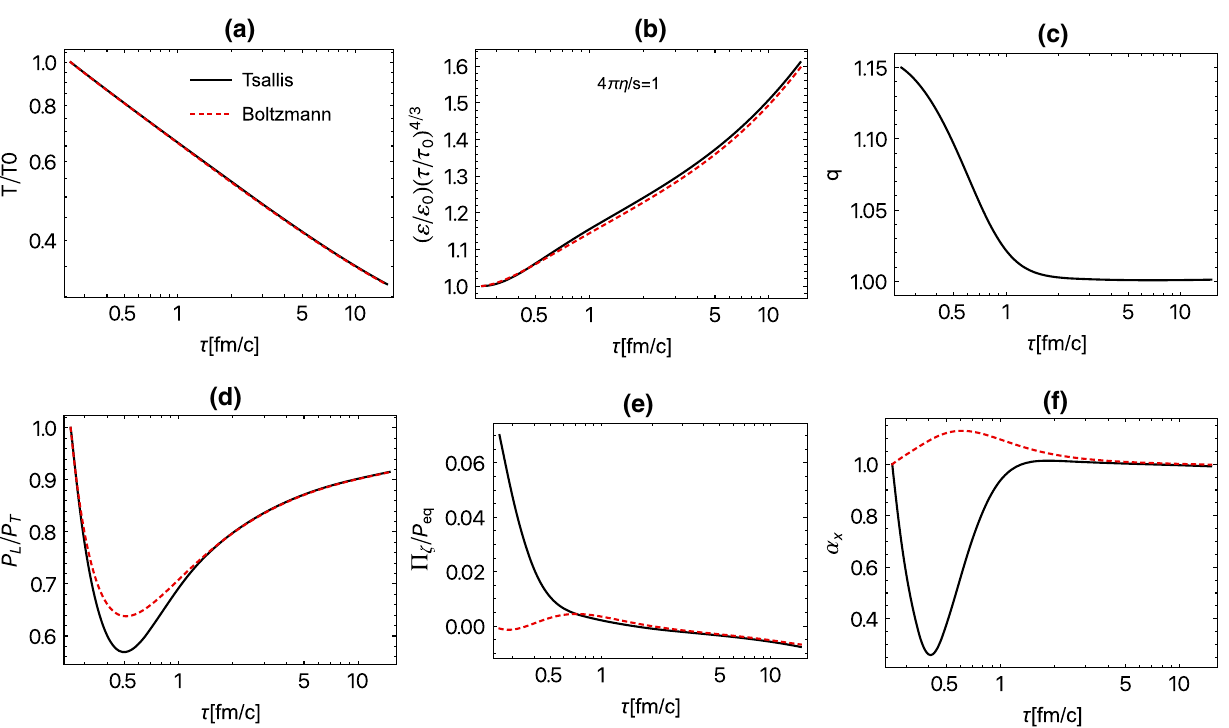
Fig. 1 Top row: proper-time evolution of scaled effective tempera- ture, scaled energy density, and the Tsallis parameter. Bottom row: proper-time evolution of the pressure anisotropy, bulk pressure, and the anisotropy parameter α x . The black solid line represents results